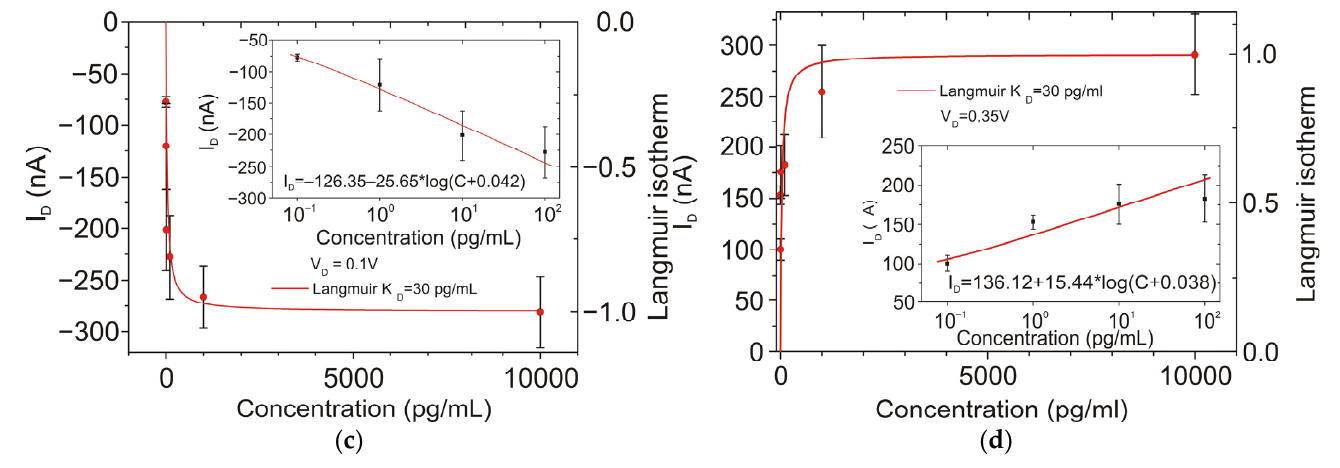
Figure 3. The GFET sensor response to NT-proBNP in 0.1 × PBS (pH 7.4). ( a ) Transfer curves after stabilization for each NT-proBNP concentration (0.1, 1, 10, 100, 1000, and 10,000 pg/mL) in 0.1 × PBS with no washing steps, with applied V DS = 50 mV. ( b ) Change in Dirac point for increasing NT-proBNP concentration. ( c ) I D change for each NT-proBNP concentration at a fixed gate voltage V G = 100 mV with respective Langmuir binding isotherm. Inset: the linear range for low-concentration response. ( d ) I D change for each NT-proBNP concentration at a fixed gate voltage V G = 350 mV with respective Langmuir binding isotherm. Inset: the linear range for low-concentration response.